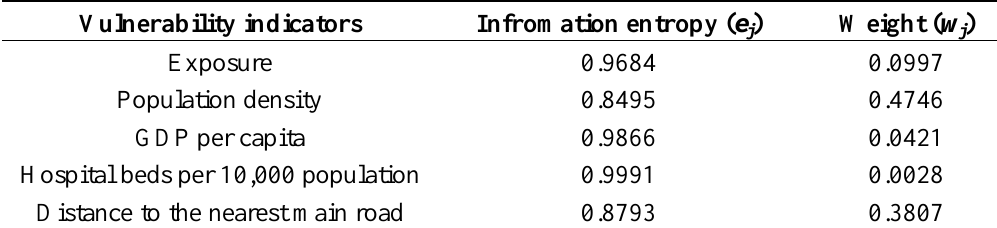
Table 2. Information entropies and weights of vulnerability indicators.